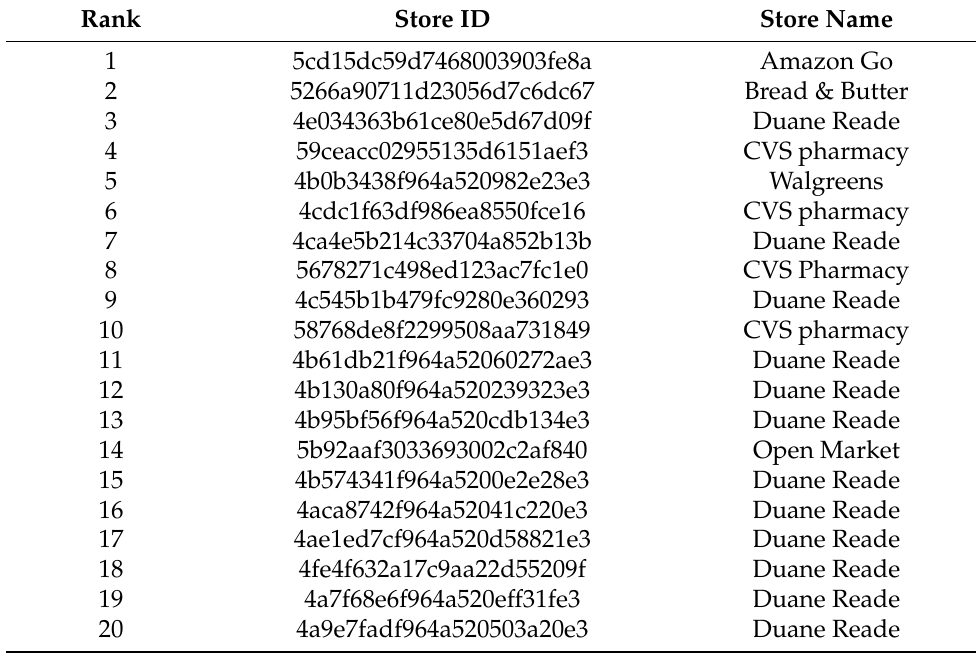
Table 8. Ground truth—stores ranked based on FourSquare visitor